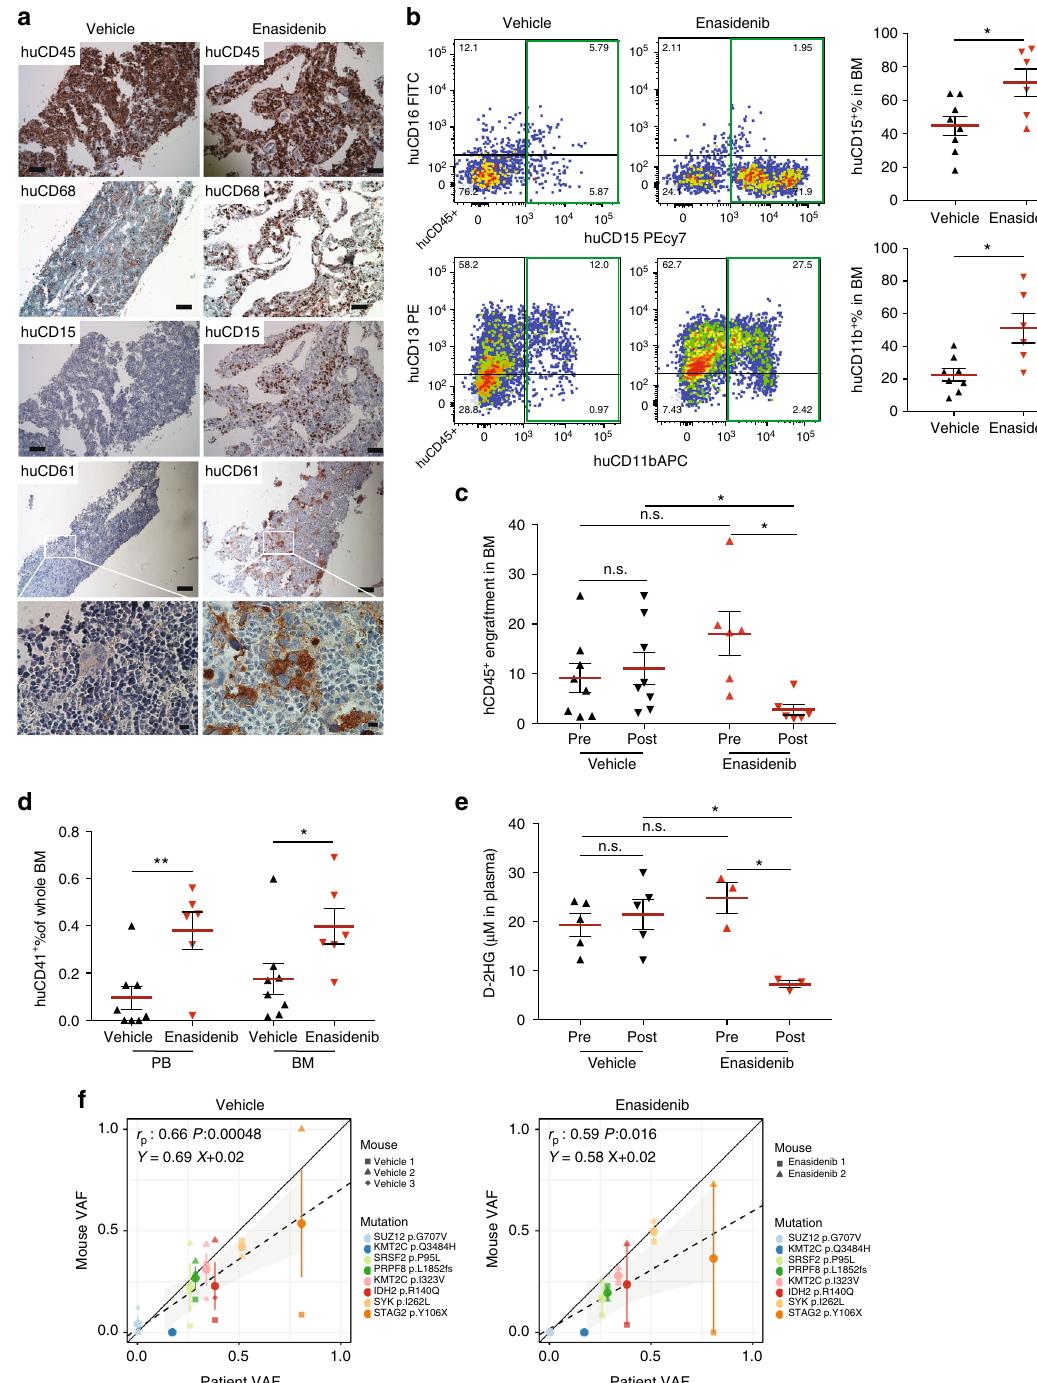
Fig. 6 MISTRG replicate granulocytic and megakaryocytic differentiation in response to inhibition of mutant isocitrate dehydrogenase 2 (IDH2) in vivo. a In vivo treatment of mutant IDH2 R140Q in MDS-EB-2 (Y021)-engrafted MISTRG mice with the IDH2 MUT inhibitor enasidenib. Representative histologic images of vehicle-treated ( n = 8, left) and enasidenib-treated ( n = 6, right) mice engrafted with MDS-EB-2 (Y021). Immunohistochemistry (IHC) stains for huCD45, huCD68, huCD15, and huCD61 (scale bars 100 µ m, original magni fi cation 10×; high-power fi eld 10 µ m, original magni fi cation 60×). b Representative fl uorescence-activated cell sorting (FACS) plots showing myeloid maturation in response to enasidenib and quantitation of huCD15 + and huCD11b + expression in vehicle- versus enasidenib-treated MISTRG mice. c Comparison of human engraftment in bone marrow (BM) from vehicle-treated ( n = 8) and enasidenib-treated ( n = 6) MISTRG mice. d Quantitation of huCD41 + expression in peripheral blood (PB) and BM from vehicle-treated ( n = 8) and enasidenib-treated ( n = 6) MISTRG mice. e Quantitation of D-2-HG in plasma of pre- and post-administration of vehicle or enasidenib. Individual mice are represented by symbols with mean ± S.E.M.; statistics represent Mann – Whitney test; n.s. not signi fi cant, * p < 0.05, ** p < 0.01 for aggregate NSG vs. MISTRG. f Representation of variant allele frequencies (VAFs) of driver mutations in vehicle-treated (left) or enasidenib-treated (right) MISTRG ( y -axis) plotted against the patient ’ s VAFs ( x -axis). Individual mice represented by symbol shape, mutations color coded. Linear regressors, Pearson's correlations, and p values between patient and xenograft VAFs are